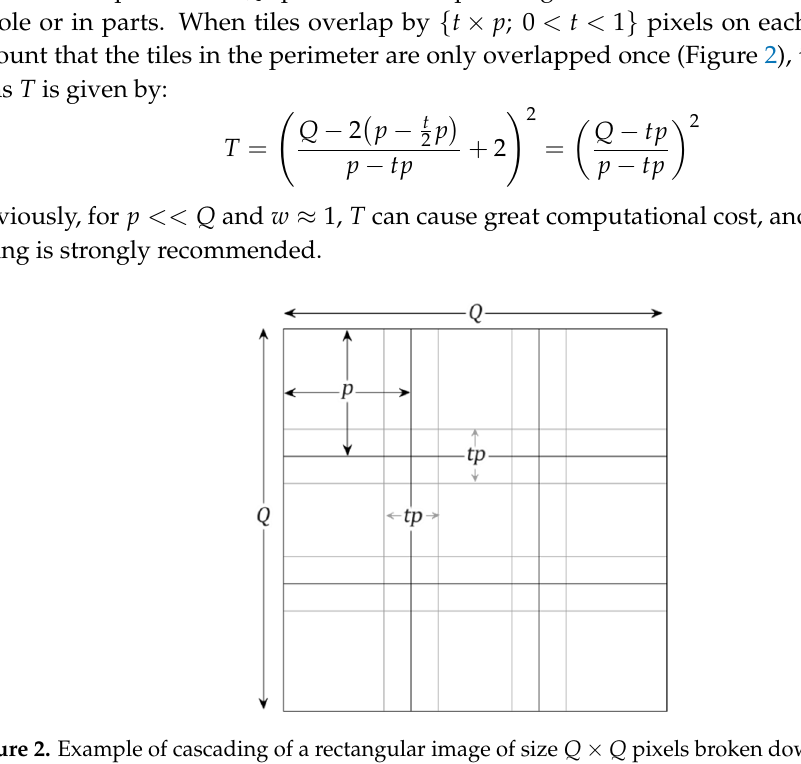
Figure 2. Example of cascading of a rectangular image of size Q × Q pixels broken down in tiles of size p × p that overlap by t × p .